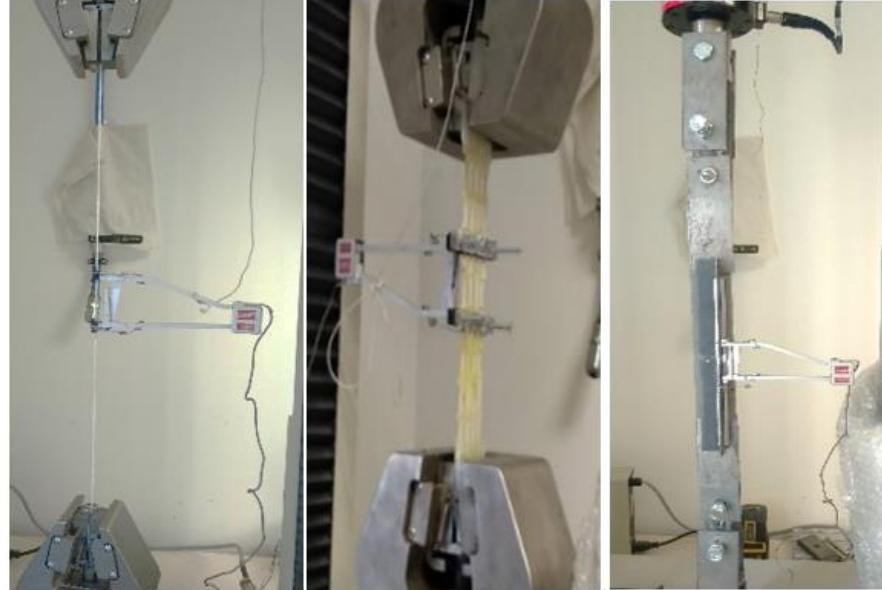
Figure 3. Tensile test setup: yarns ( left ), meshes ( middle ), FRCM ( right ).